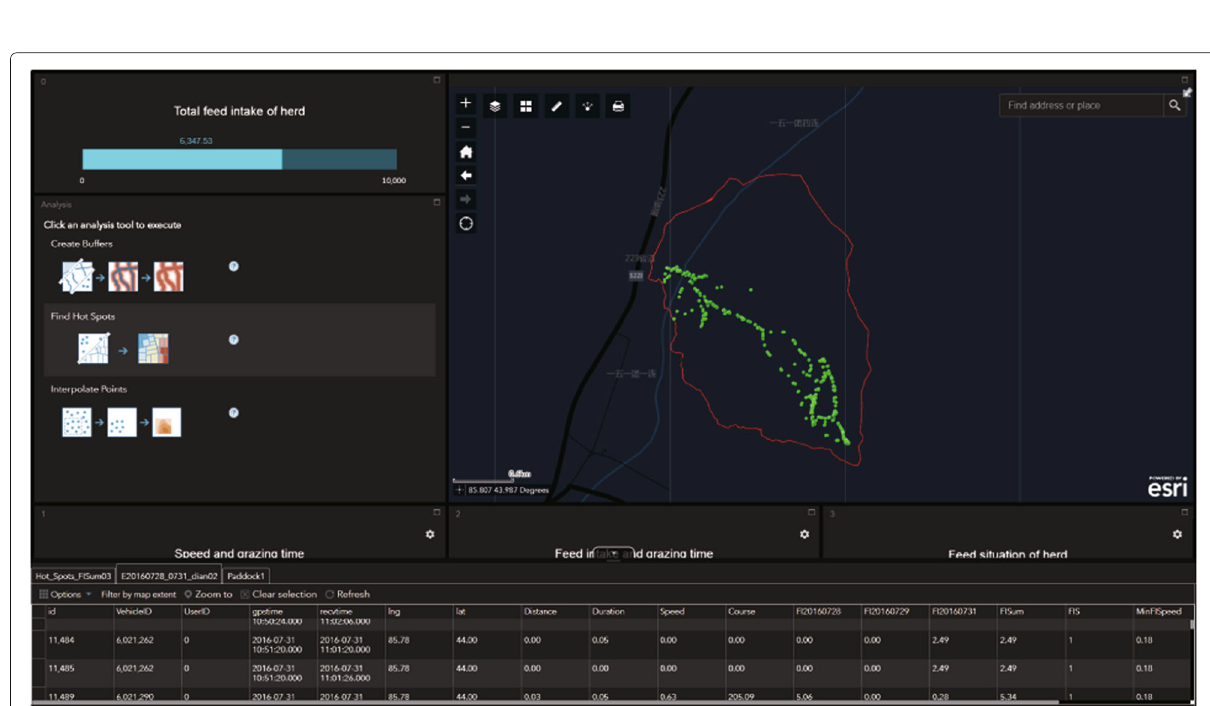
Fig. 8 The attribute table of the